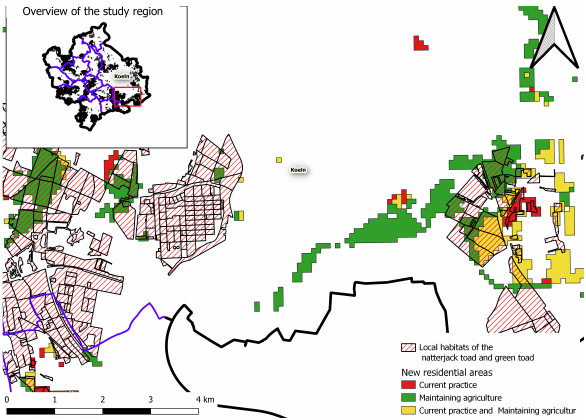
Figure 5. Example of fragmentation of areas with high value for nature conservation by new residential areas. The example area is located in the south of Cologne. Nature conservation value is expressed at the example of the Natterjack Toad and the Green